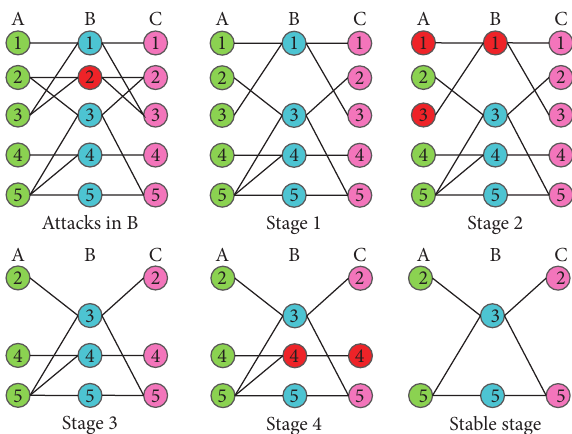
Figure 5: An example of the local model for describing the cas- cading failures on multipartite networked systems subject to node failures. Initially, node 2 from partite set B is removed. In Stage 1, the local model considers the LCC of the bipartite network G AB containing the nodes in A and B. In Stage 2, the nodes that are not are removed. In Stage 3, the local model in the LCC of G AB considers the LCC of the bipartite network G containing the BC nodes in B and C. In Stage 4, the nodes that are not in the LCC of G are removed. The above process continues until no further BC node removal is possible. The remaining subnetwork in the stable stage is considered as the LCC of the focal network.